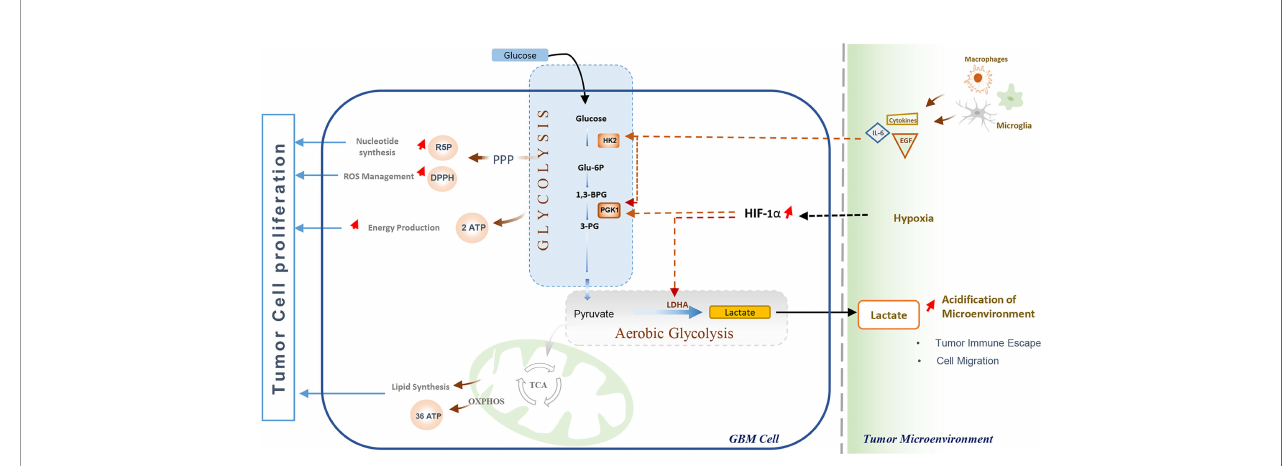
FIGURE 3 | Glycolysis and its role in Glioblastoma cell proliferation and immune escape. The Warburg effect enables GBM cells to meet their energy demand through rapid ATP production, and promotes nucleotides synthesis and oxidative stress management, promoting cell proliferation. The elevated lactate production by tumor cells increases the acidi fi cation of the Tumor Microenvironment, which disturbs immune cells activation leading to impaired tumor immunosurveillance and cell migration. Immune cells (tumor-associated macrophages and Microglia) enhance glycolysis through Interleukin-6 (IL-6) and Epidermal Growth Factor (EGF), While hypoxic conditions in the Tumor microenvironment promote glycolysis and Warburg effect by activation and stabilization of hypoxia-inducible transcription factor (HIF-1 a